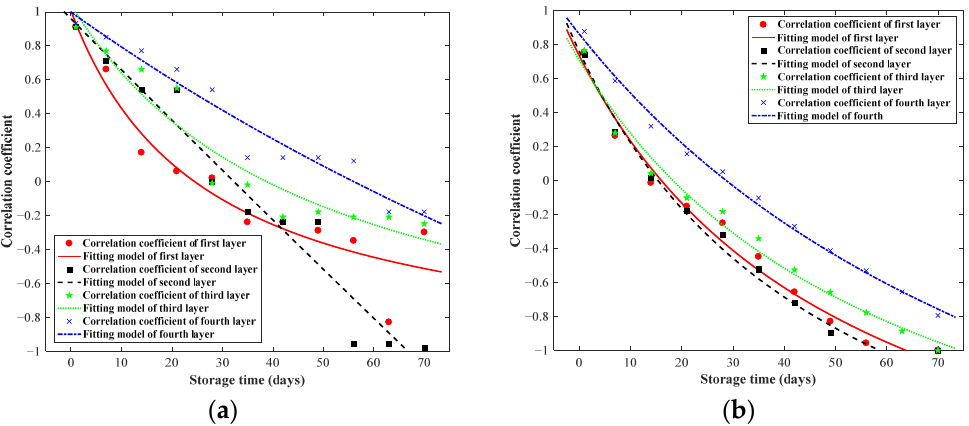
Figure 6. The model of grain temperature correlation coefficient threshold on the YOZ plane. ( a ) Fitting models of clustering results with DBSCAN. ( b ) Fitting models of clustering results with 3 σ . Table 4. Model parameters of grain temperature correlation coefficient threshold on the YOZ plane.